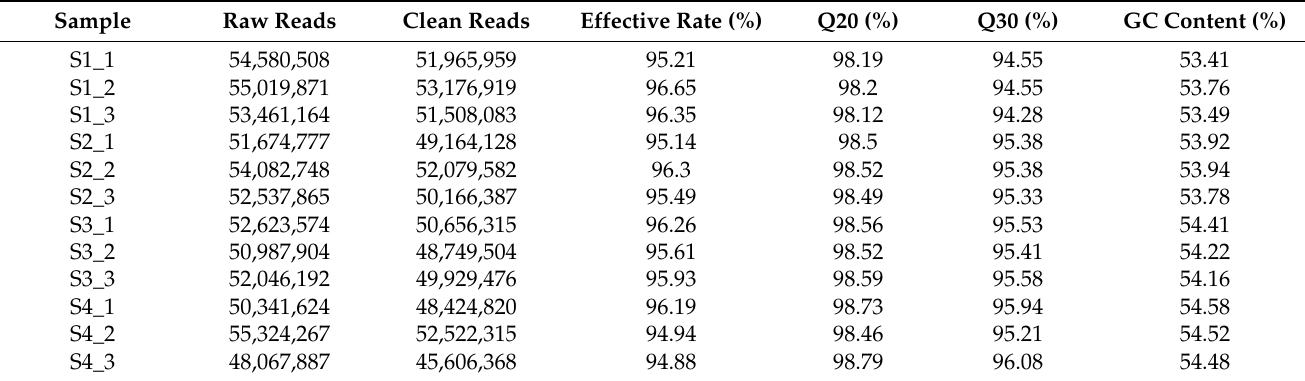
Table 1. Sequencing quality test results of dual RNA-seq.